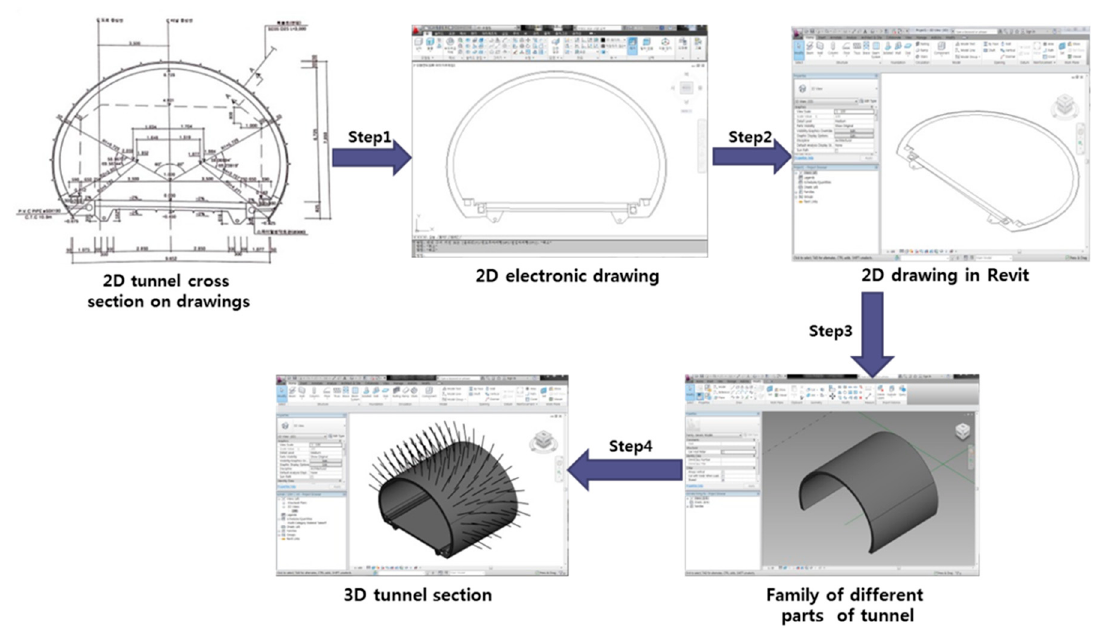
Figure 4. The process of creating the 3D tunnel section.